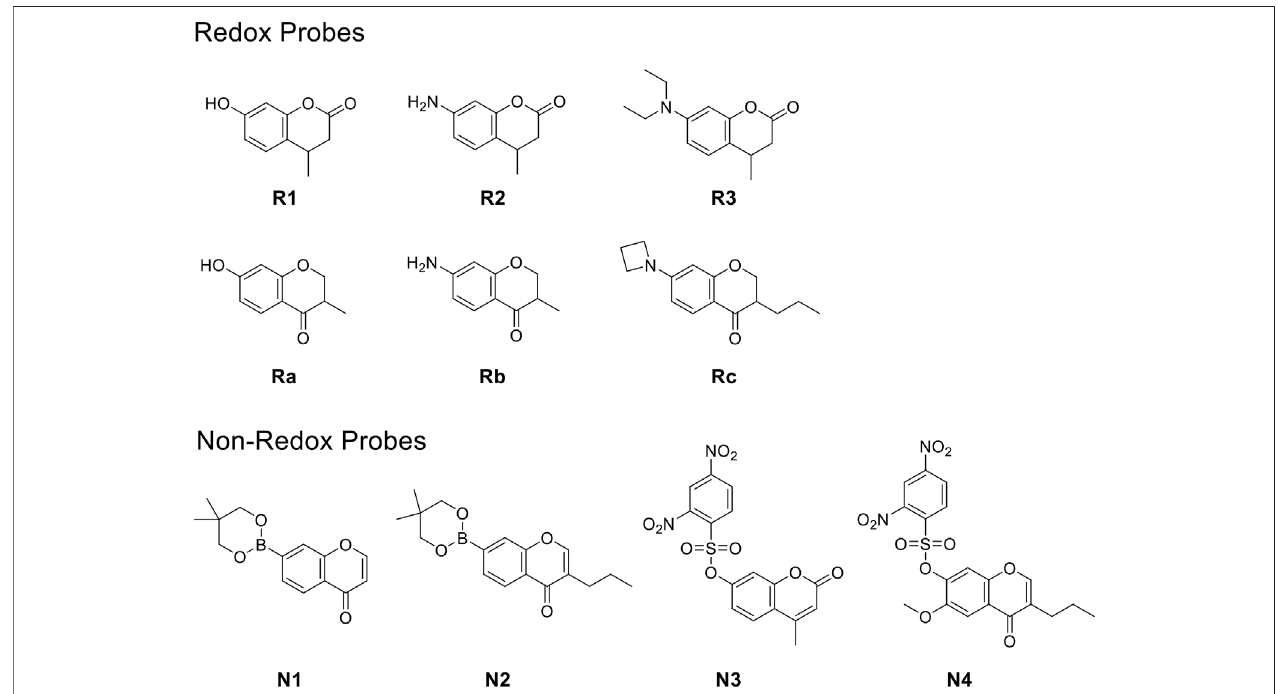
FIGURE 2 | The redox- and non – redox-based superoxide anion probes designed and synthesized in this study. Coumarin and chromone were selected as the core fl uorophores.